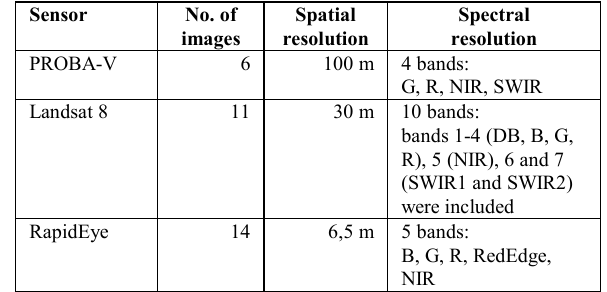
Table 1. Overview of data used in the topographic correction study and validation.